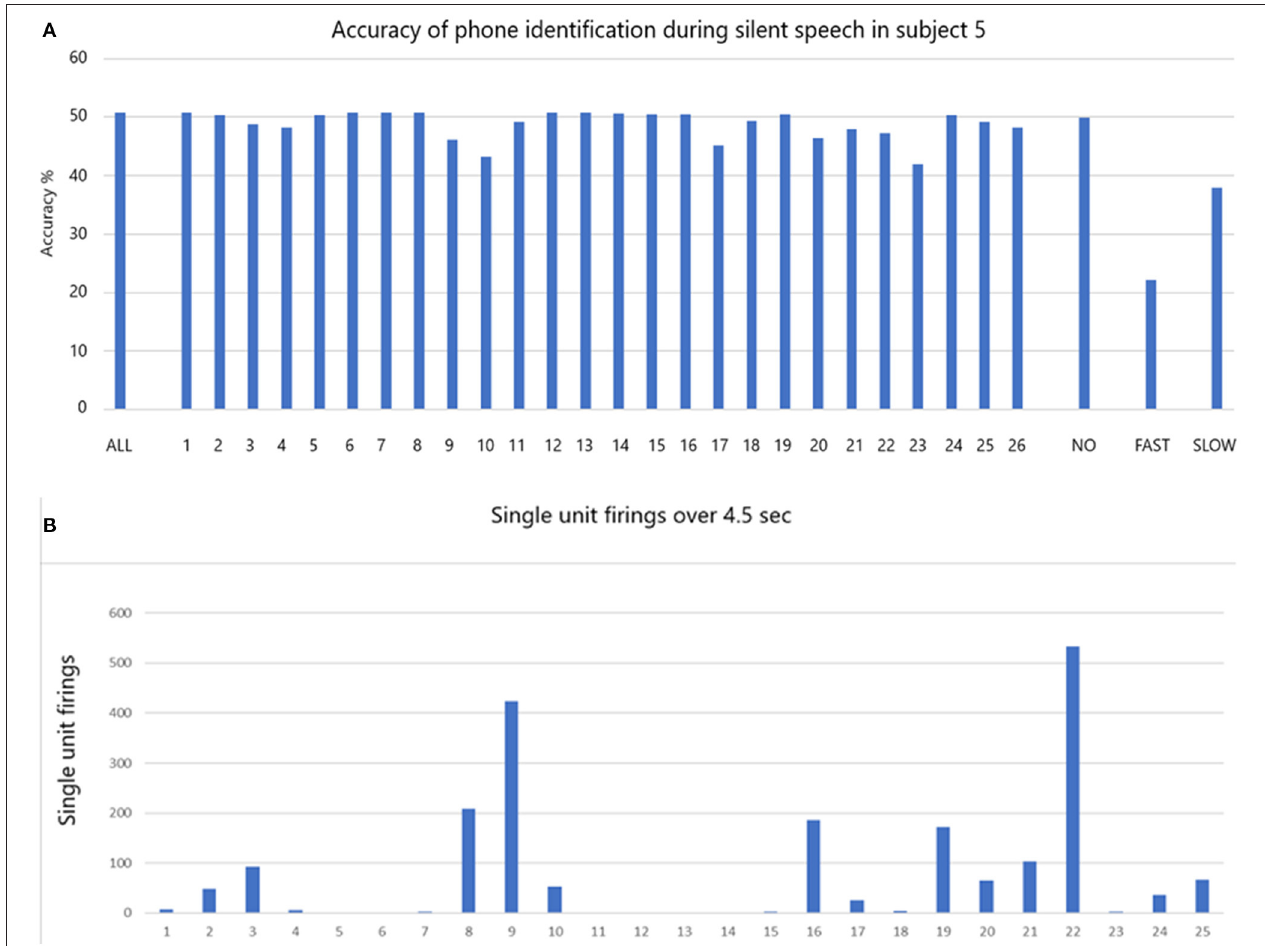
FIGURE 6 | (A) The accuracy of phone identification during silent speech in participant 5 is 50.7% when ALL are included (left bar). Excluding each single unit in sequence may change the accuracy. When the non-firing single units are excluded (NO) the accuracy remains the same. When FAST firing are excluded the accuracy drops as shown. When the slow firing are excluded the accuracy also drops as shown. (B) The total number of firing for all is shown over the whole session that lasted